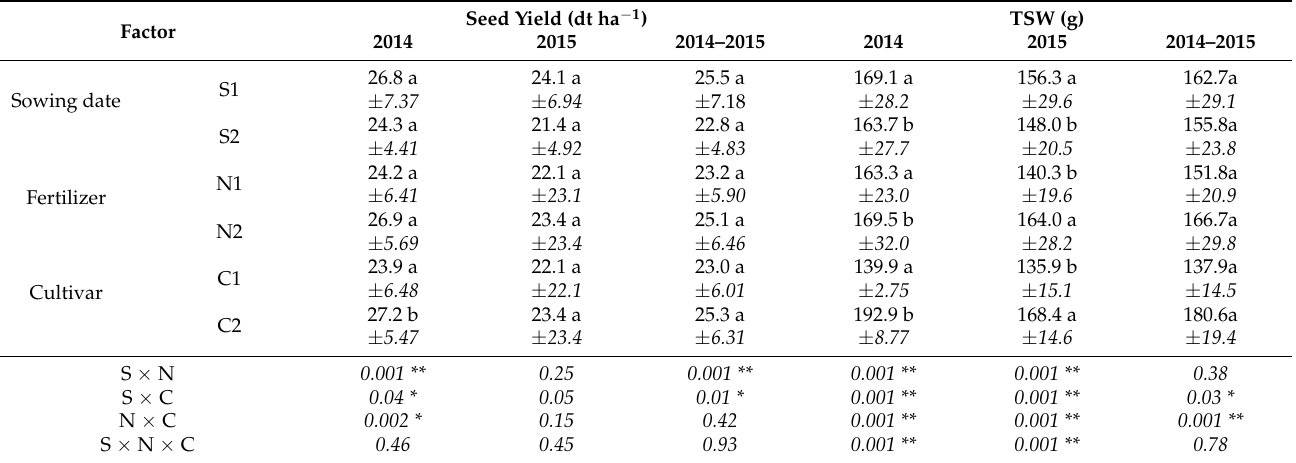
Table 2. Comparison of yield and TSW of soybean depending on sowing date, fertilization and